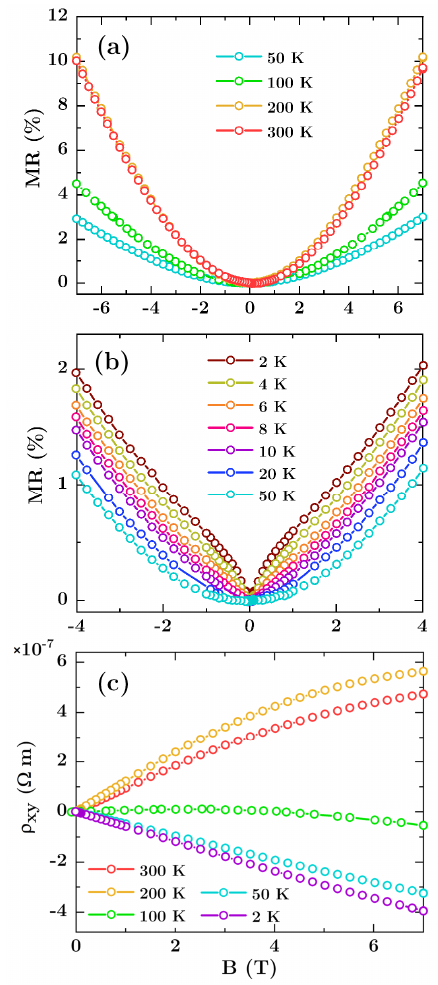
Figure 4. ( a , b ) Longitudinal magnetoresistance (MR) and ( c ) Hall transverse magnetoresistance vs field curves for Bi antidot arrays with antidot size of 65 nm. The results of the Hall measurements for temperature range 4 K–20 K were omitted for clarity, since they are similar to those obtained at 2 K and 50 K.